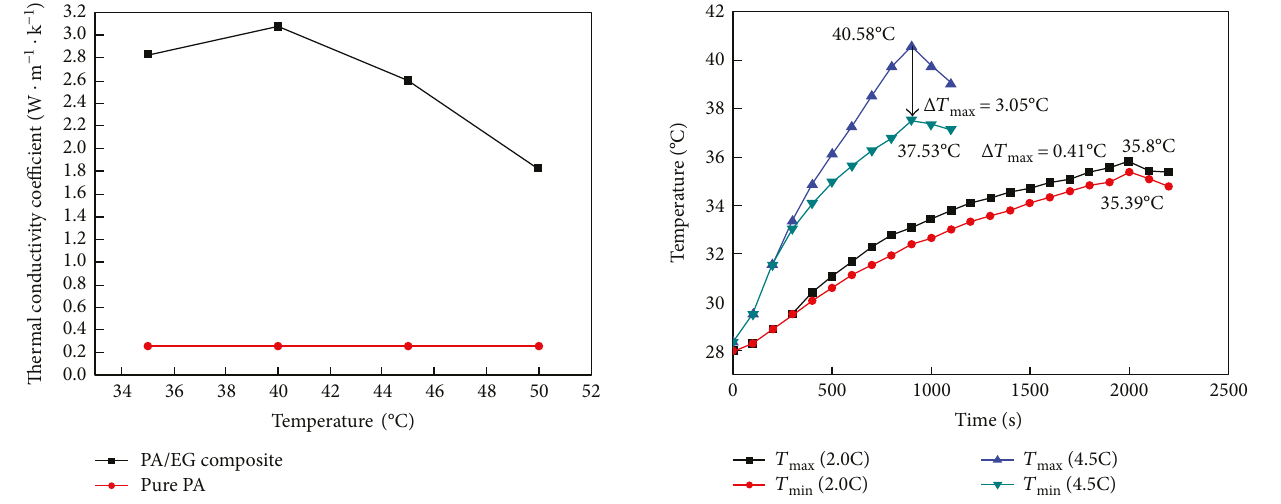
Figure 8: The T and T comparisons of battery module with max min PCM cooling at 2C and 4.5C, respectively ( T meant number max 4 cell; T meant number 1 cell). min